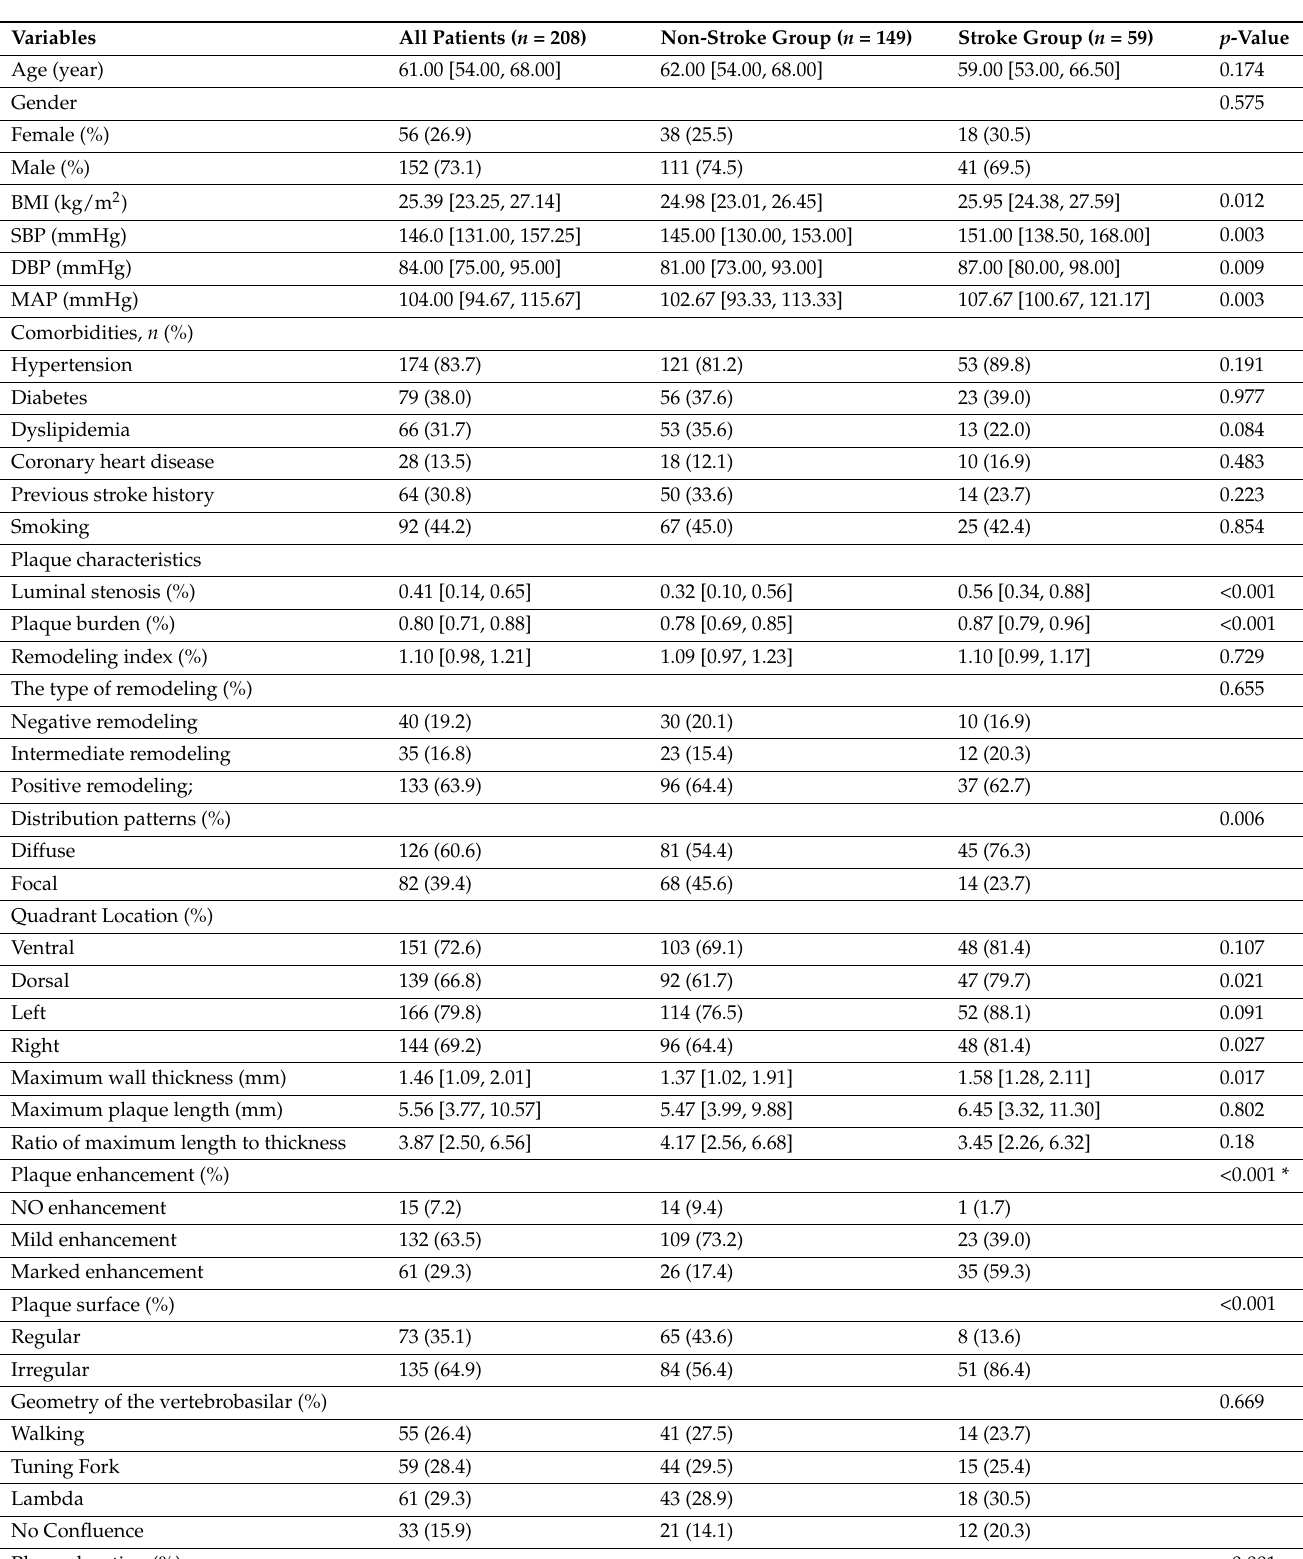
Table 1. Clinical and intracranial plaque characteristics of study population and comparison between stroke and non-stroke